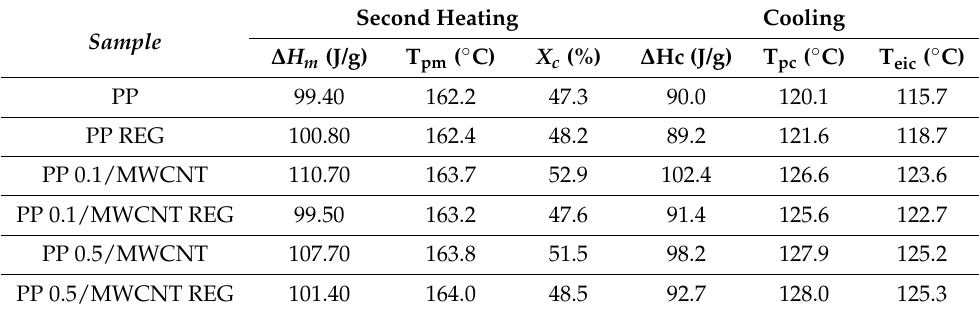
Table 2. Results of thermal properties (tensile) of PP and PP/MWCNT